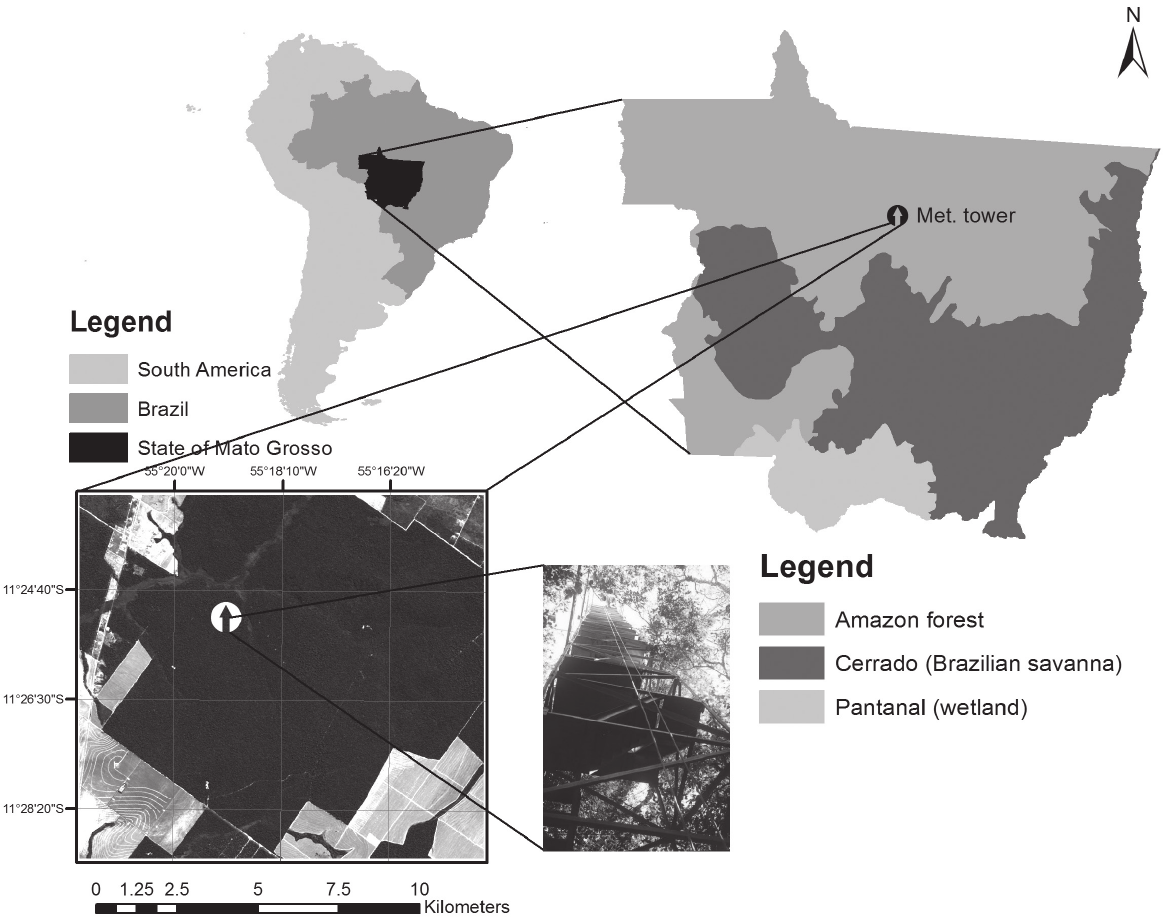
Fig. 1 - Location of the micrometeorological tower in in the Amazon-Cerrado transitional